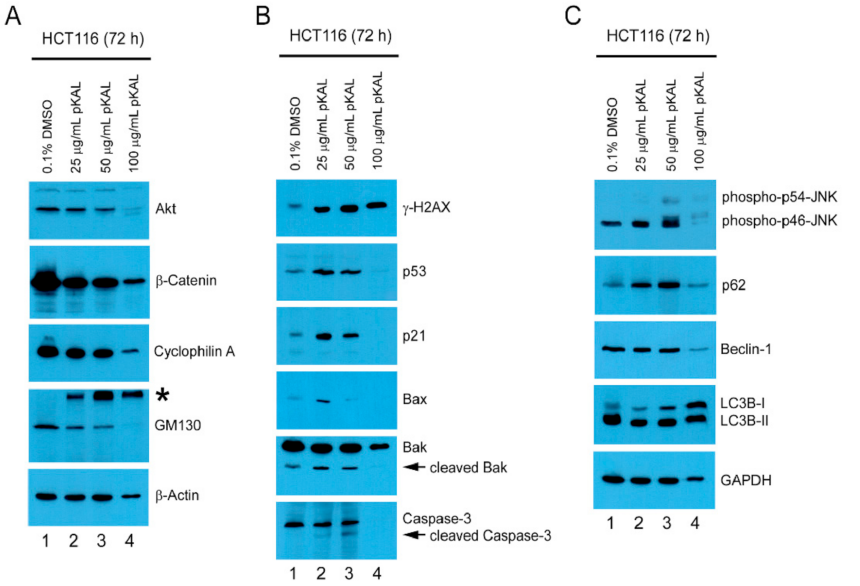
Figure 4. pKAL-induced cell death mechanisms in p53 wild-type HCT116 cells: HCT116 cells were grown on a 10 cm culture dish with DMSO or pKAL treatment for 72 h at the indicated amount. Cells were analyzed by Western blot using the indicated antibodies: ( A ) downregulation of Akt-mediated survival proteins by pKAL. The asterisk indicates the high-molecular-weight post trans- lational modified form of GM130; ( B ) upregulation of apoptosis-related proteins by pKAL. The arrow indicates the low-molecular-weight cleaved form of the corresponding protein; ( C ) upregulation of autophagy-related proteins by